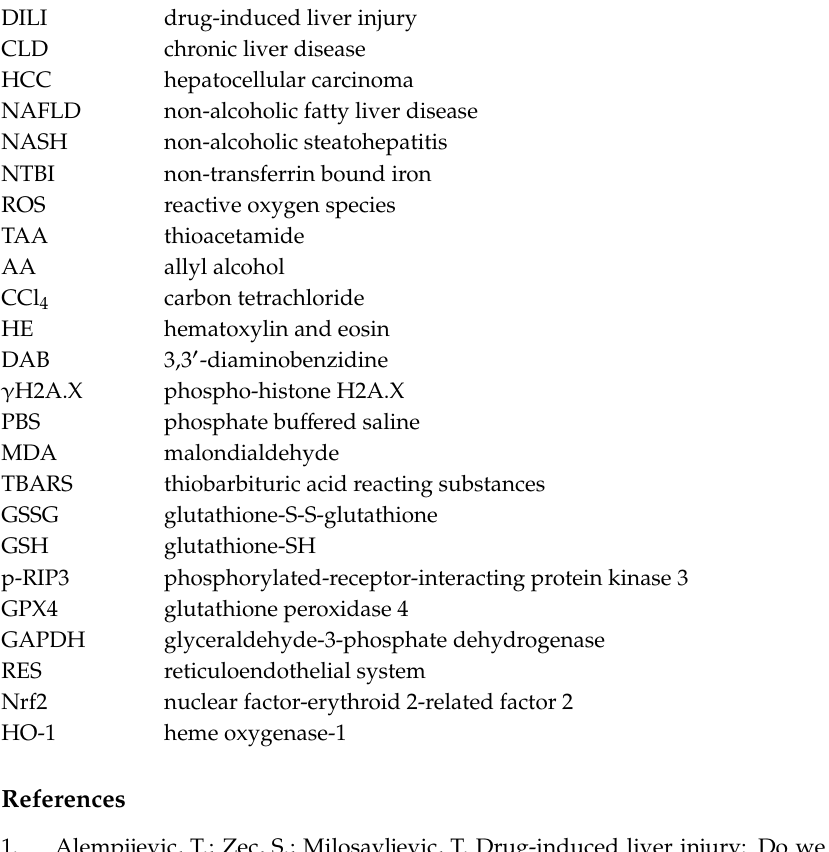
Figure S1: The grey-scale image of total protein bands in polyacrylamide gels stained with Coomassie brilliant blue, Figure S2: Representative images of iron histochemistry in the centrilobular (A) and periportal (B) regions of the liver of Fe-saline group, Figure S3: Representative images of iron histochemistry in the liver of Cont-CCl4 (A) and Fe-CCl4 (B) groups. Figure S4: Hepatic expression of heme oxygenase-1 analyzed by Western blot using anti-heme oxygenase-1 antibody (M175, Takara, Kusatsu, Japan). Signals were developed by ECL prime